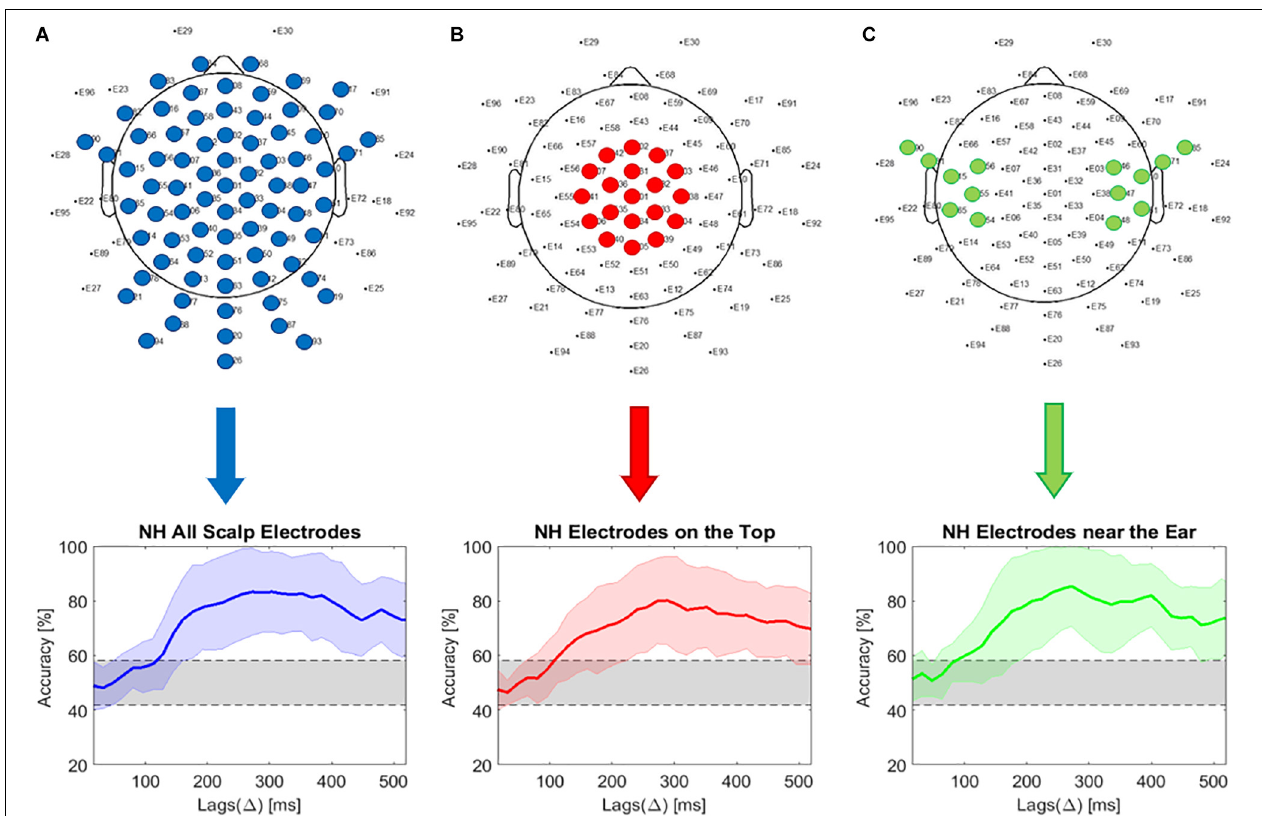
FIGURE 3 | Comparison of electrode locations. (A) Selective attention decoding accuracy using all electrodes (eye electrodes 29 and 30 and scalp EEG electrodes spared at the position of the cEEGrid are excluded from the analysis); (B) Selective attention decoding accuracy using 19 electrodes on the top of scalp; (C) Decoding accuracy using 14 electrodes in the area next to the